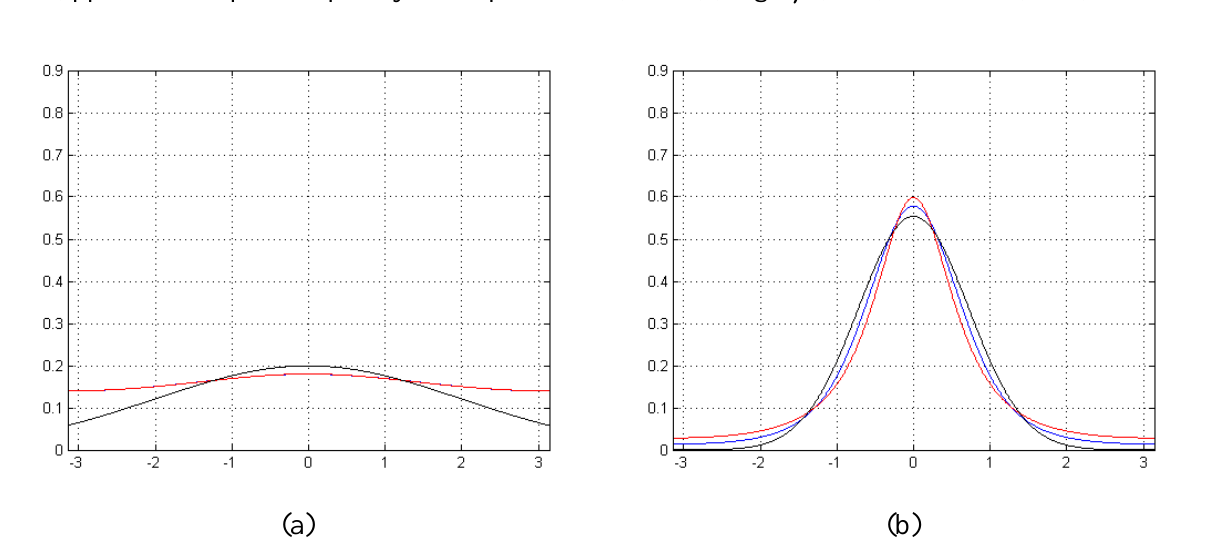
Figure 1. Probability density function of MRI phase signal noise, real pdf (blue), approximated pdf (red), Gaussian pdf (black): (a) low  (0.08) and SNR (-20 dB) case (approximated pdf completely overlaps real one) and (b) high  (0.75) and SNR (4 dB)